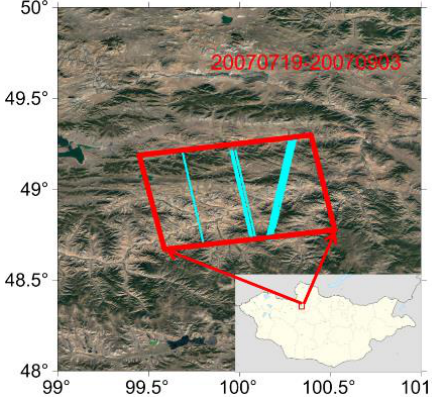
Figure 10. The footprint of the ALOS-1 PALSAR images over the Moron region and the spatial coverage of the ICESat/GLAS data over the study area.